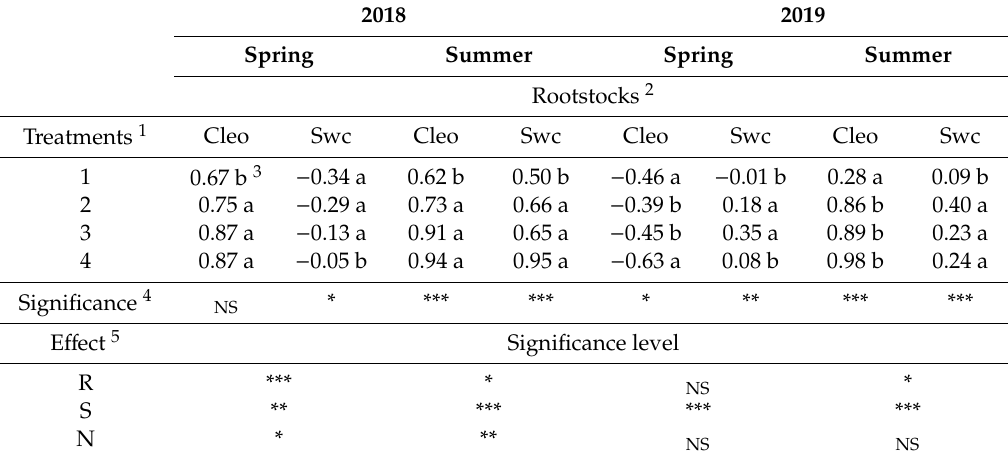
Table 1. E ff ect of rootstock and soil-applied plant nutrition on the leaf area index (LAI) and analysis of variance (ANOVA) of Huanglongbing (HLB)-a ff ected Hamlin citrus trees during the 2017–2019 seasons at Immokalee,